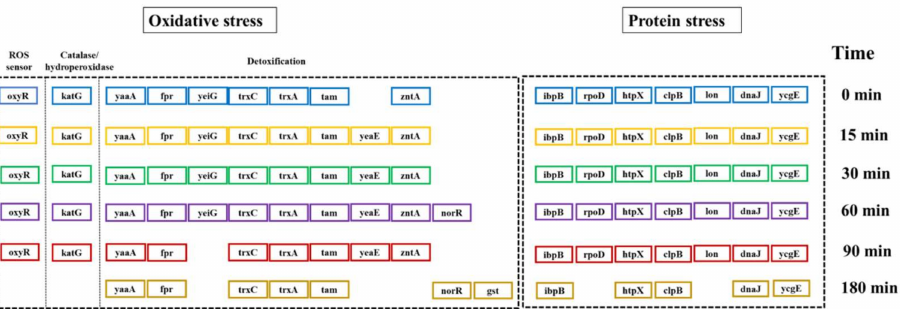
Figure 4. Major stress response pathways and biomarker genes showed altered expression (TELI gene > 1.5) during the electrochemical oxidation of HMX. The genes were clustered into subcate- gories based on their functions and involvement in various pathways (Table